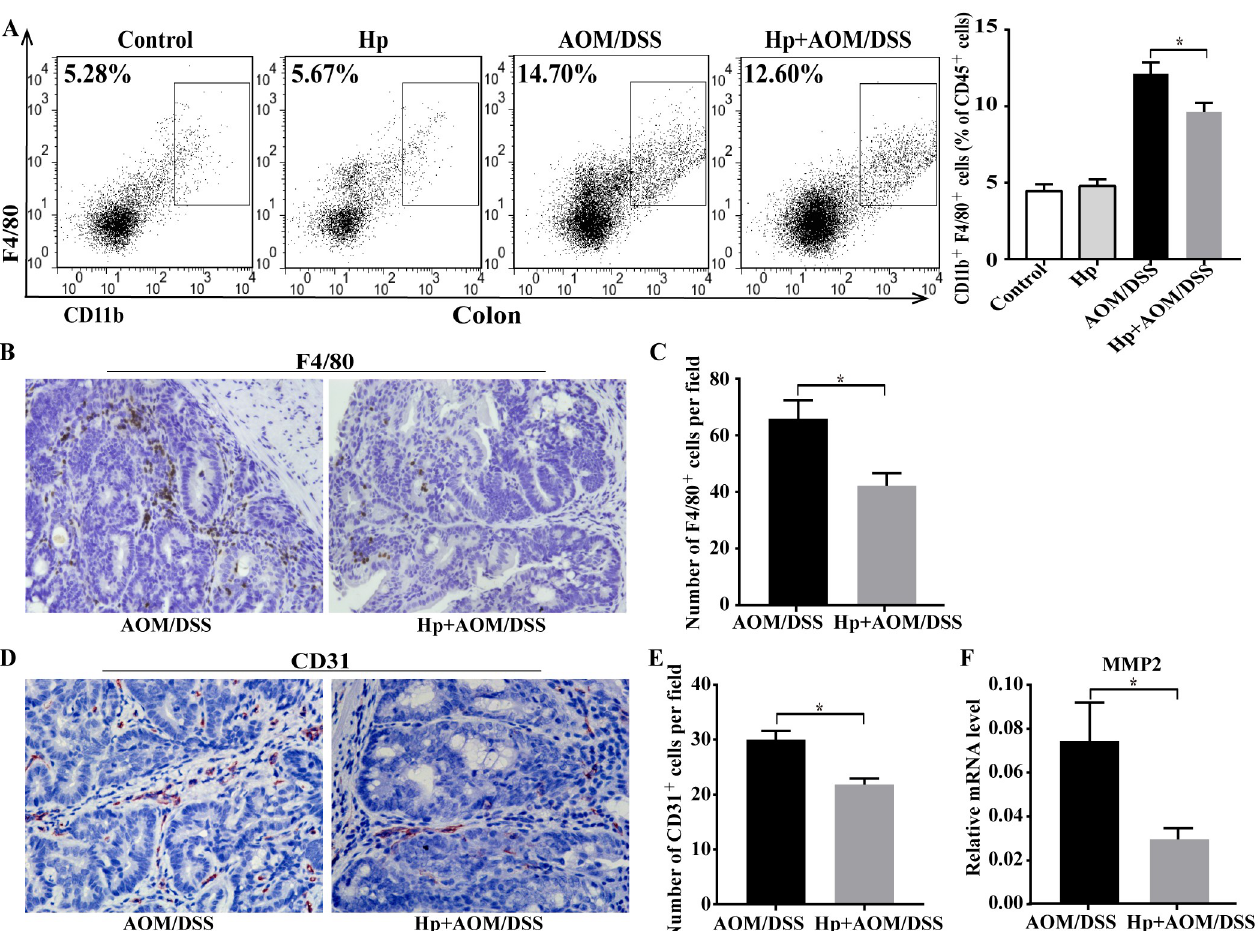
Fig 3. H . pylori infection decreased TAMs infiltration in CAC. (A) Flow cytometry analysis of CD45 + CD11b + F4/80 + TAMs in colonic tissues from AOM/ DSS-treated group (AOM/DSS) and AOM/DSS-treated with H . pylori infection group (Hp+AOM/DSS) (n = 6/group). (B) Representative immunohistochemical images of the TAM marker F4/80 staining in tumor tissues ( × 400) and (C) the numbers of F4/80 + cells per field (n = 6/group). (D) Representative immunohistochemical images of the CD31 staining in tumor tissues ( × 400) and (E) the numbers of CD31 + cells per field (n = 6/group). (F) Relative mRNA expression of MMP2 in colonic tumor tissues (n = 6/group). Data are represented as mean ± SEM. � P < 0.05.